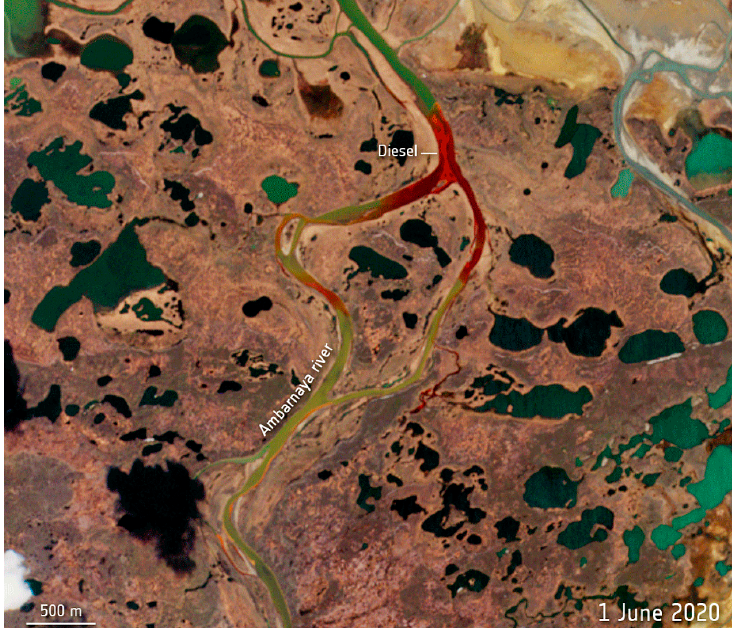
Figure 1. The Copernicus Sentinel-2 image of an oil (diesel) spill into the river Ambarnaya near Norilsk, Russia. The image, from 1 June 2020, was processed by the ESA and has been made available under CC BY-SA 3.0 IGO license at https://www.esa.int/ESA_Multimedia/Images/2020/06/Arctic_Circle_oil_spill (accessed on 8 January 2023).